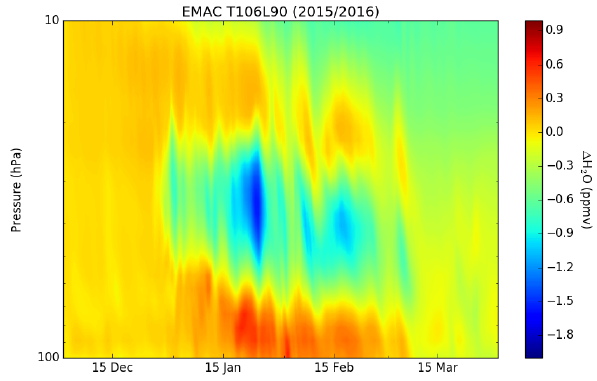
Figure 6. Redistribution of H 2 O ( (cid:49) H 2 O) as simulated with EMAC T106L90 at northern high latitudes (70–90 ◦ N) as a function of pressure during the 2015/2016 Arctic winter (difference of total hydrogen 2CH 4 + H 2 O at time t and total hydrogen at time t 0 = 1 December ( (cid:49) H 2 O = (2CH 4 + H 2 O)( t ) − (2CH 4 + H 2 O)( t 0 )).